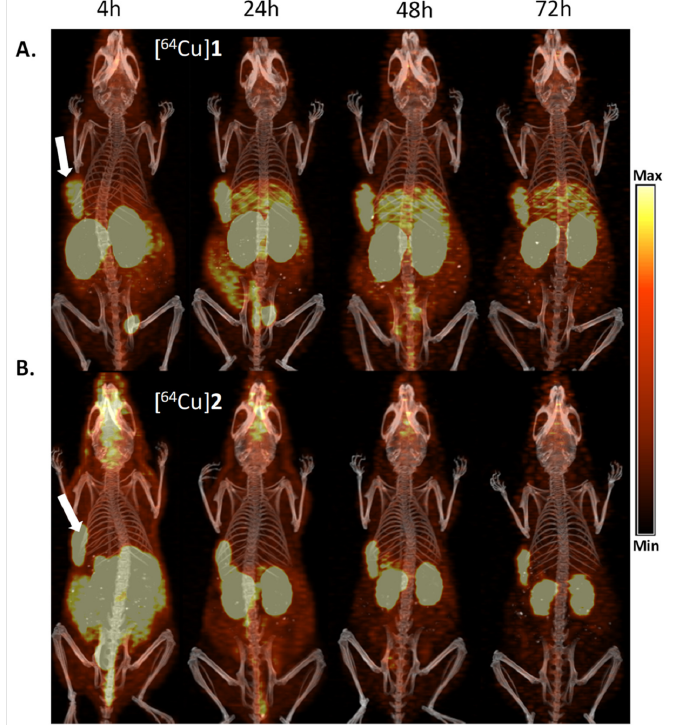
Figure 6. PET/CT imaging. Representative whole-body coronal maximum intensity projections (MIPs) of PET/CT images of mice bearing BxPC-3 xenograft tumors at 4 h, 24 h, 48 h, and 72 h p.i. of ( A ) [ 64 Cu] 1 and ( B ) [ 64 Cu] 2 . Arrow: tumor. Decay corrected PET data are shown in color, CT data in